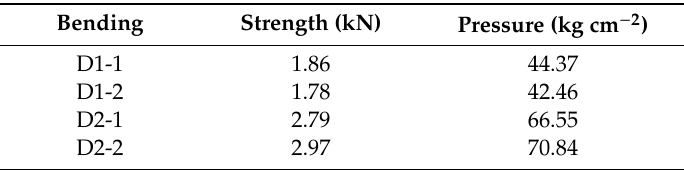
Table 6. Bending strength assay results after 28